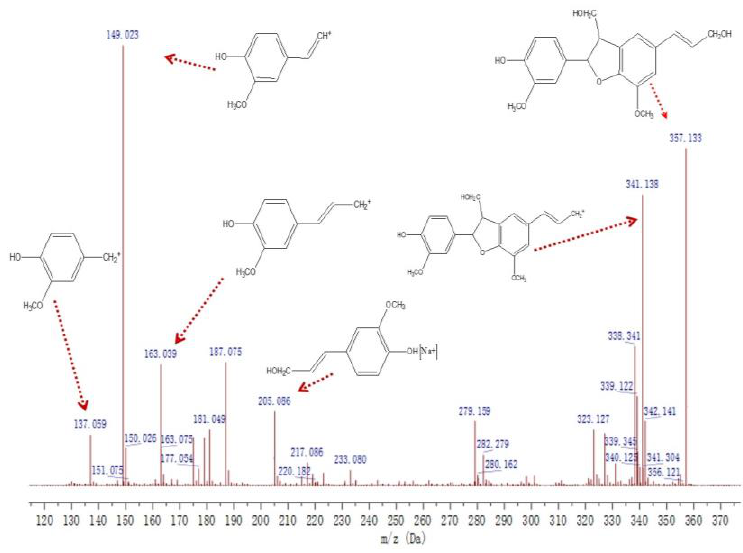
Figure 11. Mass spectrum of the compound G 1 .